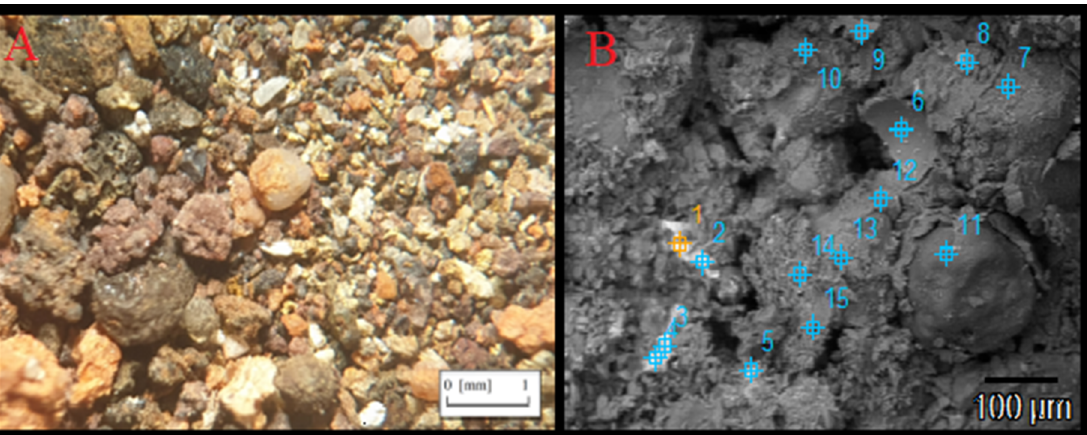
Figure 7. Microphotograph under reflected polarized light showing the grains of the initial soil taken from the heap ( A ) and microphotograph BSE of the soil sample with the points of microanalysis ( B ).